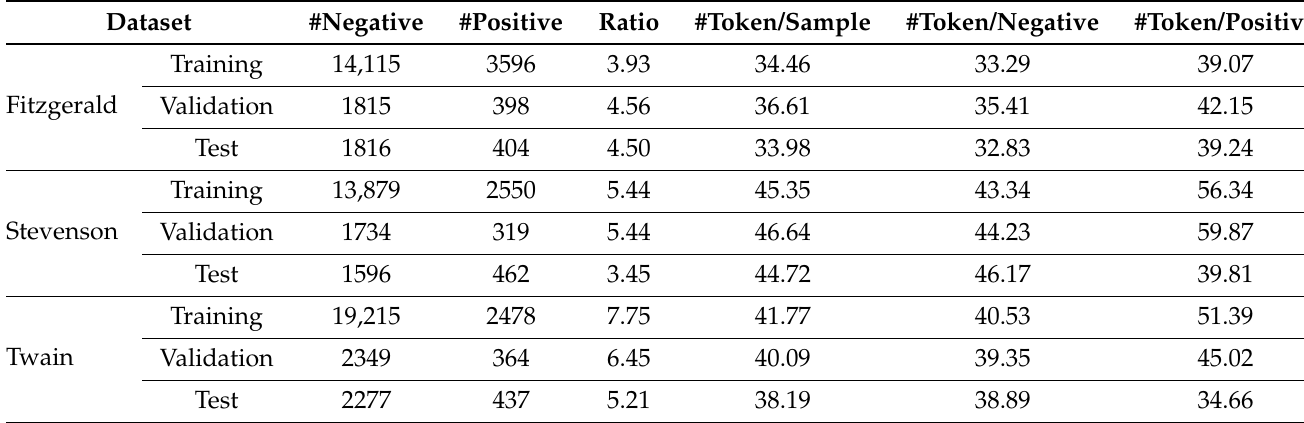
Table 2. Statistics of each dataset showing the number of positive and negative samples, and their ratios in each dataset. Numbers of tokens per each sample were also